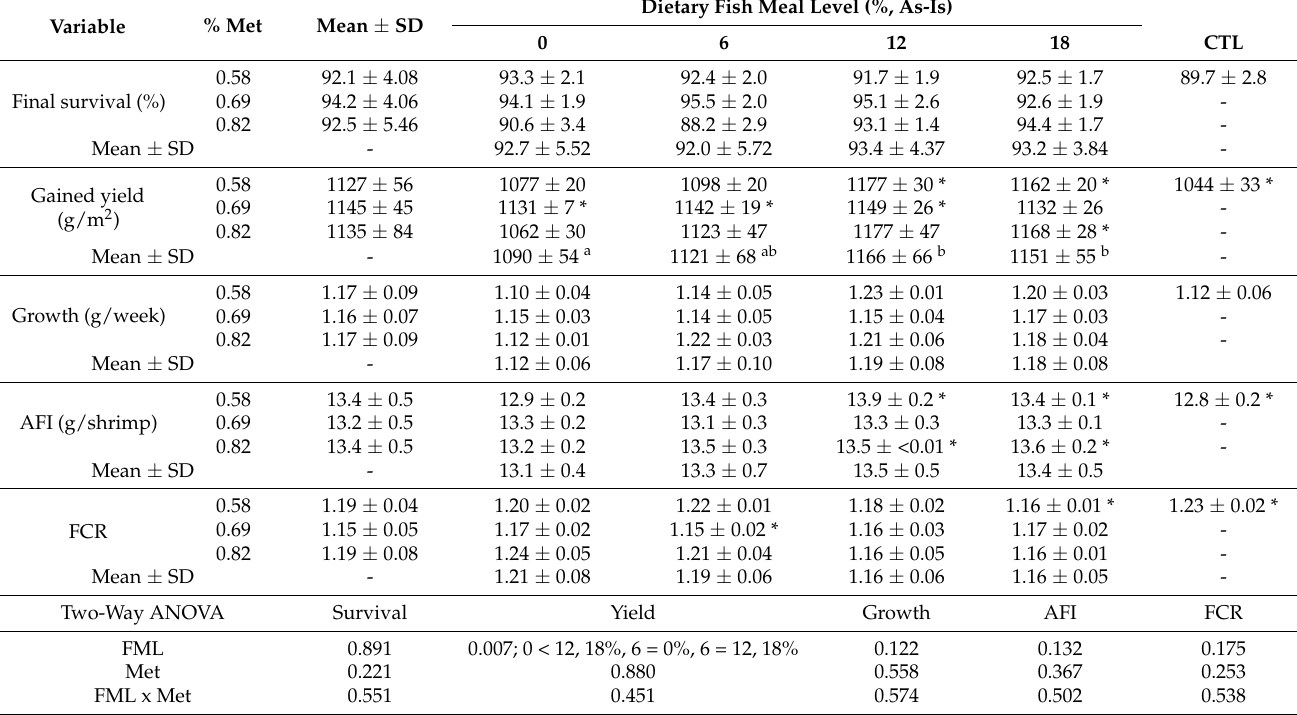
Table 5. Final shrimp growth performance (mean ± SD) in outdoor 1 m 3 tanks as a function of dietary methionine (Met) and fish meal (FML) inclusion levels. Shrimp of 1.00 ± 0.08 g were raised with 100 animals/m 2 for 70 days. Asterisks (*) refer to statistically significant differences between the commercial control (CTL) and the experimental diets ( p < 0.05, Student’s t -test). Common letters in each column indicate non-statistically significant differences between different dietary fish meal levels according to Tukey’s HSD test ( p >